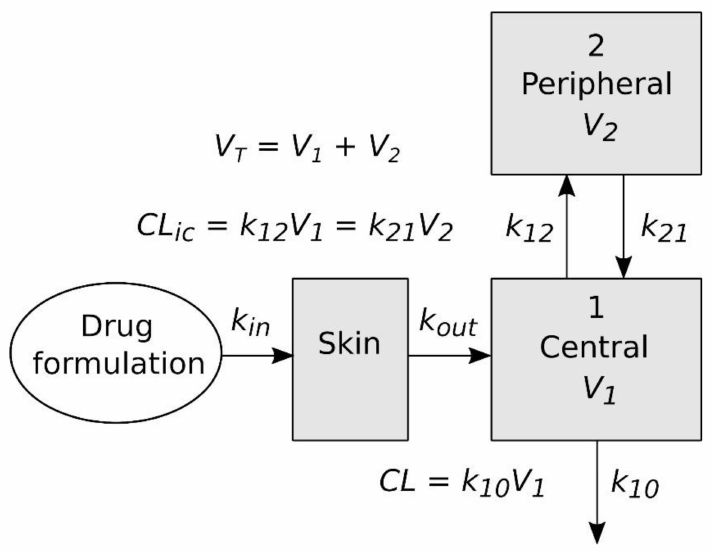
Figure 3. Schematic diagram of the three-compartment model used to simulate NT plasma con- centrations in rats dosed percutaneously with the formulated NT gel. CL : total plasma clearance, V 1 : volume of the central compartment, V 2 : volume of the peripheral compartment, V T : total vol- ume of distribution, CL ic : intercompartmental clearance, k 12 and k 21 : first-order rate constants for mass transfer between the central and the peripheral compartments, k 10 : elimination first-order rate constant.